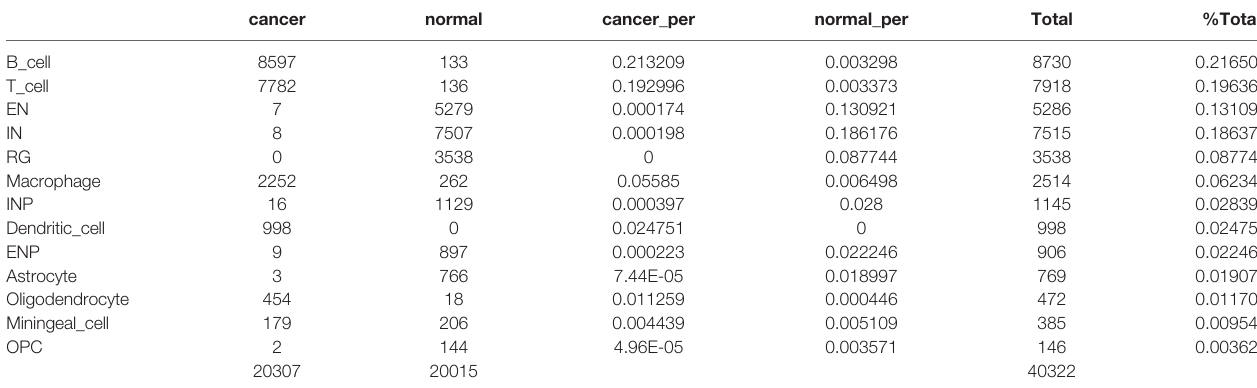
TABLE 2 | The proportion of various subgroups in PCNSL and normal